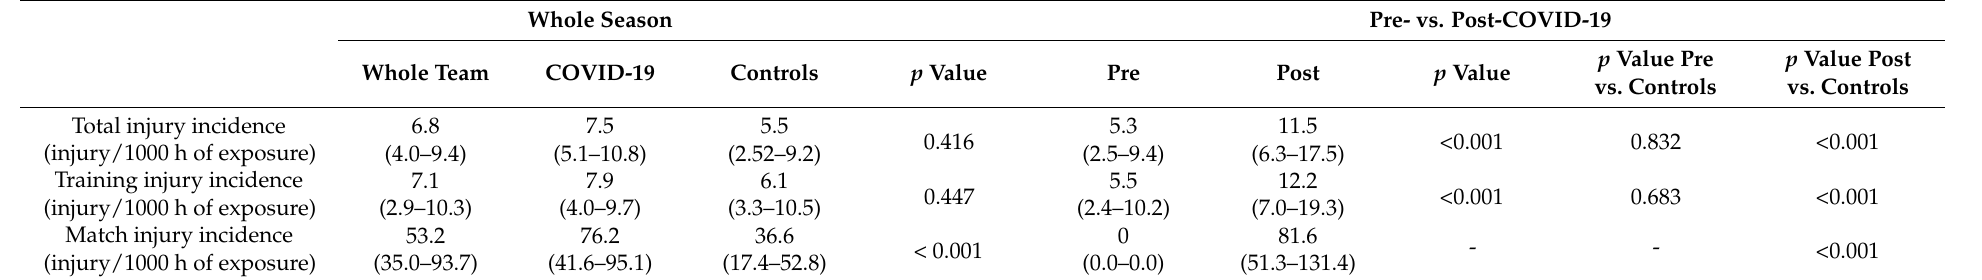
Table 4. Muscle/tendon injury incidence during training and competition in players diagnosed with COVID-19 and players who did not have COVID-19 during